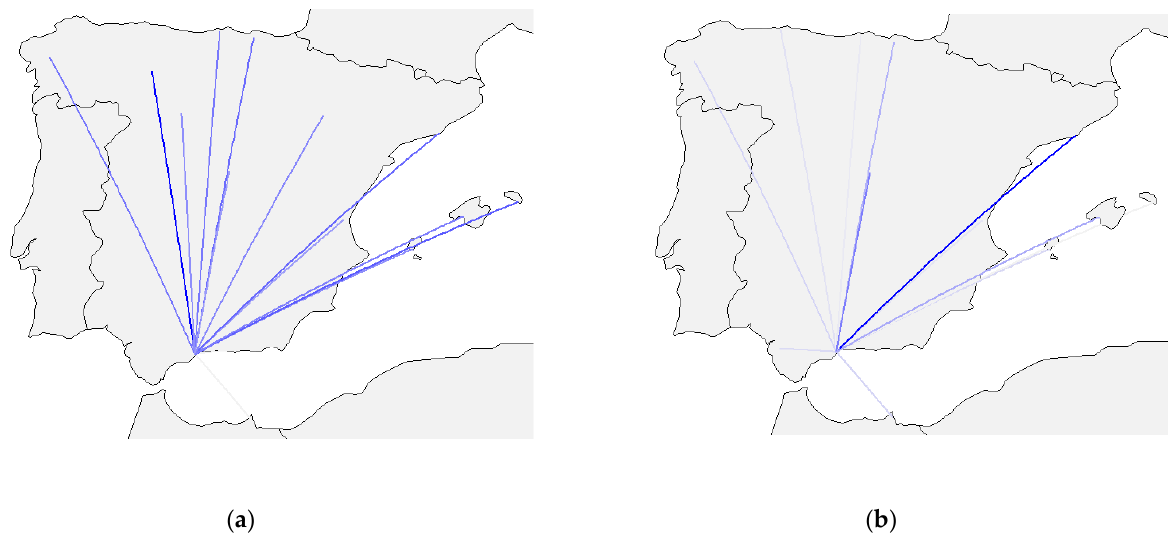
Figure 10. Carbon dioxide emissions from main domestic corridors operating in AGP airport, where a rough sketch means more emissions than the thinner one as follows: ( a ) Partial emission per pas- senger and route (arithmetic average: 75.69, standard deviation: 22.37); ( b ) Total emission of routes concerned. Source: own elaboration from the data provided by [19,20].